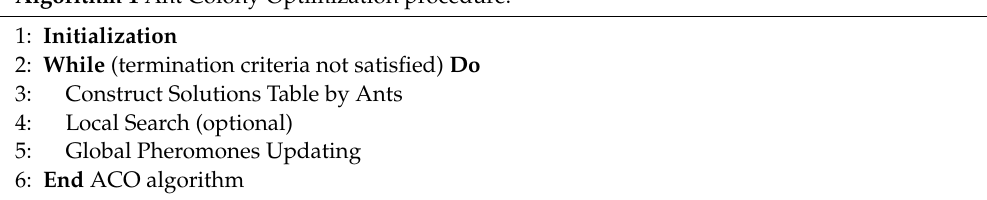
Algorithm 1 Ant Colony Optimization procedure.